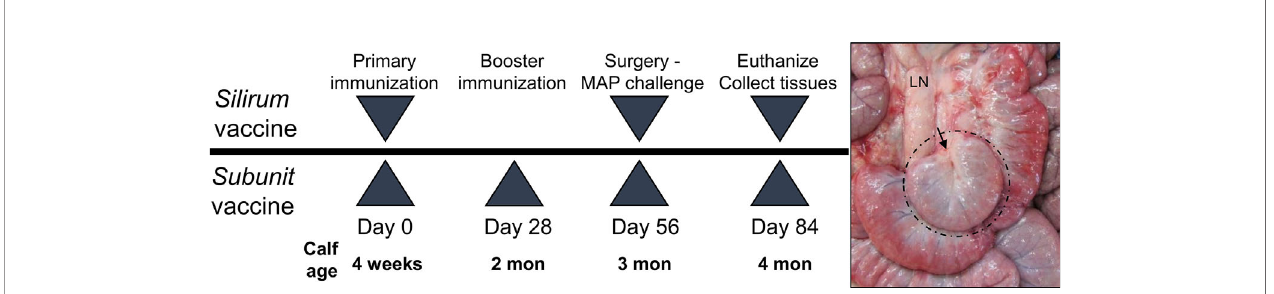
FIGURE 1 | Vaccine study designs. Silirum vaccine study: Six, 4-week old calves received a single subcutaneous dose of the Silirum ® vaccine (CZ Veterinaria S.A., Spain) and six other calves received adjuvant alone (MONTANIDE ™ ISA 61 VG). Subunit vaccine study: Six calves were subcutaneously injected with adjuvant alone (30% Emulsigen ™ , 250 µg CpG ODN) and an additional three groups (six calves per group) were each injected with one of three pools of 5 recombinant Mycobacterium avium ssp. paratuberculosis (MAP) proteins using a homologous prime-boost regimen. On Day 56 intestinal segments were surgically prepared and 10 10 CFU MAP injected into the lumen. A representative in situ image of an intestinal segment at 28 days post-infection (Day 84) in a four month old calf is shown with hash marks identifying the intestinal segment located among the surrounding intact intestine and the arrow indicating the site of surgical anastomosis. LN, mesenteric lymph